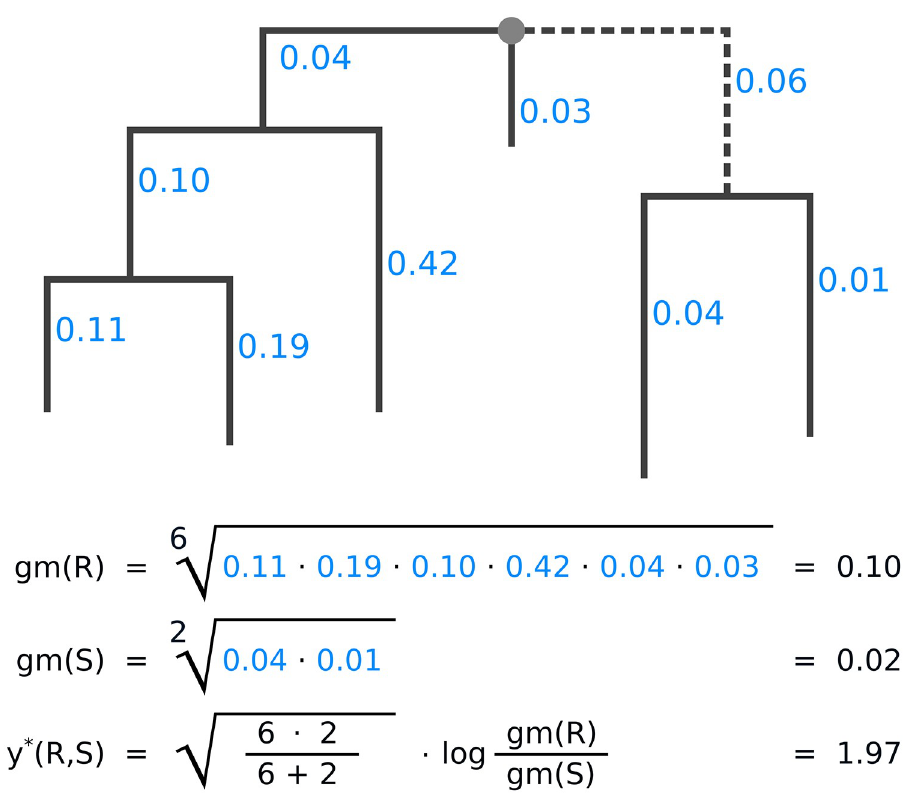
Fig 6. Example computation of the balances between two subtrees. The figure shows how the balance is computed for the two subtrees induced by the dashed edge of the tree, for one sample. Numbers next to edges are the accumulated placement mass of the sequences in the sample. We call the left hand side of the tree R, and the right hand side S, as seen from the dashed edge. For simplicity, we do not use weighting here; that is, we assume p = (1, ... , 1). First, the geometric means for both subtrees are calculated, then, their balance. The balance is positive, indicating that subtree R contains more placement mass on (geometric) average.